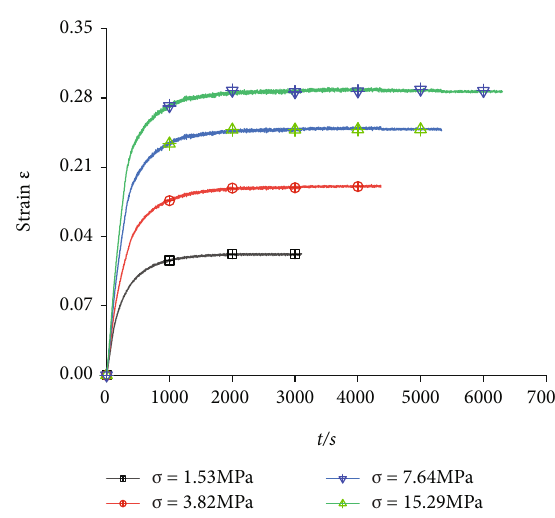
Figure 2: Test strain-time curves.